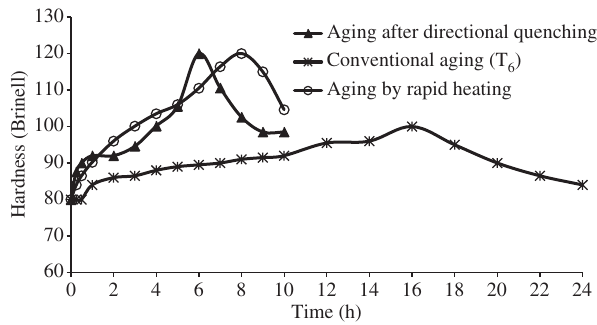
composite aged at p